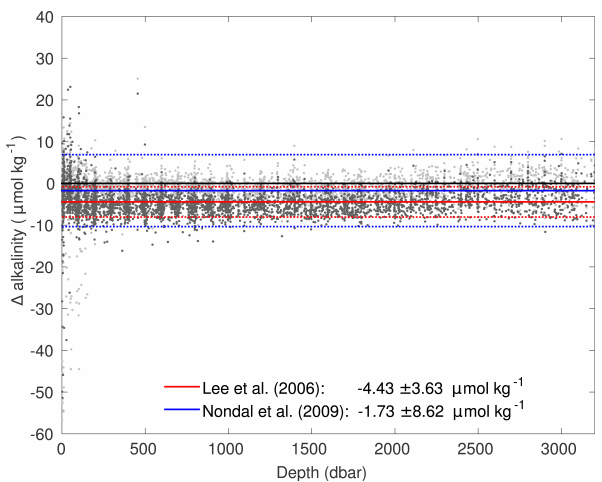
Figure A1. Difference between measured and calculated alkalinity for Irminger Sea cruise data. The dark grey dots use the salinity– alkalinity relationship following Lee et al. (2006) and the light grey dots use the relationship following Nondal et al. (2009). The solid lines represent the mean difference and dotted lines ± 1SD (1 stan- dard